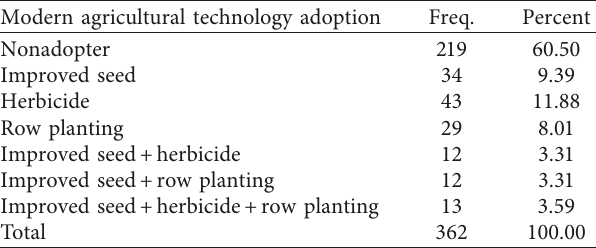
Table 4: Percentage distribution on choice variable. Modern agricultural technology adoption